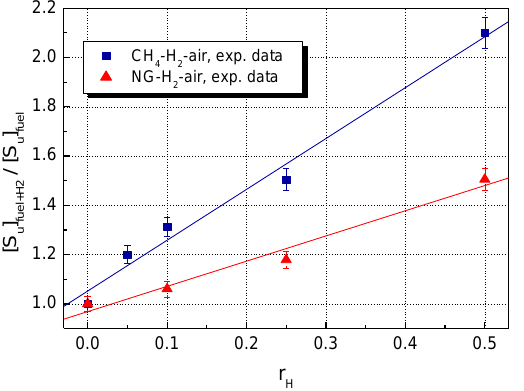
Figure 3. Experimental LBV of H 2 -blended CH 4 –air and NG–air with various hydrogen contents at ambient initial conditions.